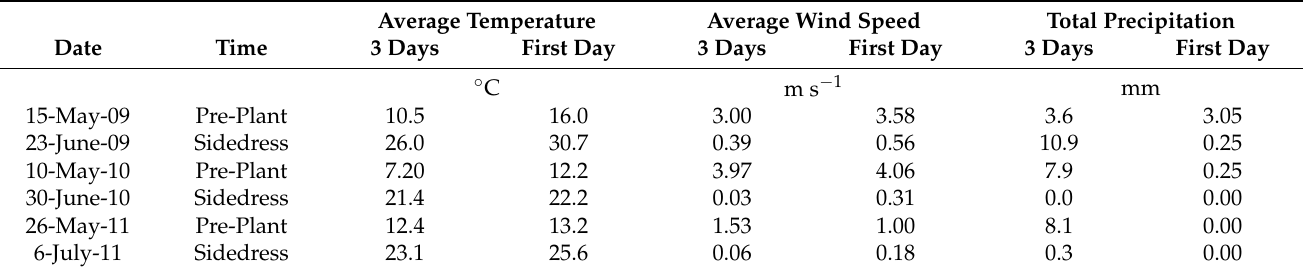
Table 3. Average air temperature, wind speed, and total precipitation during ammonia (NH 3 ) sampling periods. Average Temperature Average Wind Speed Total